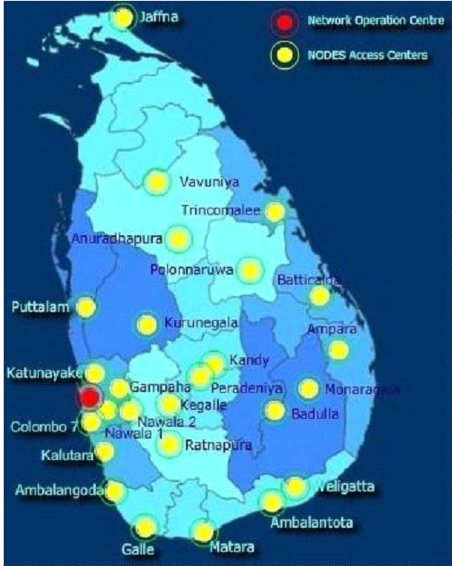
Figure 8. National online distance education service access